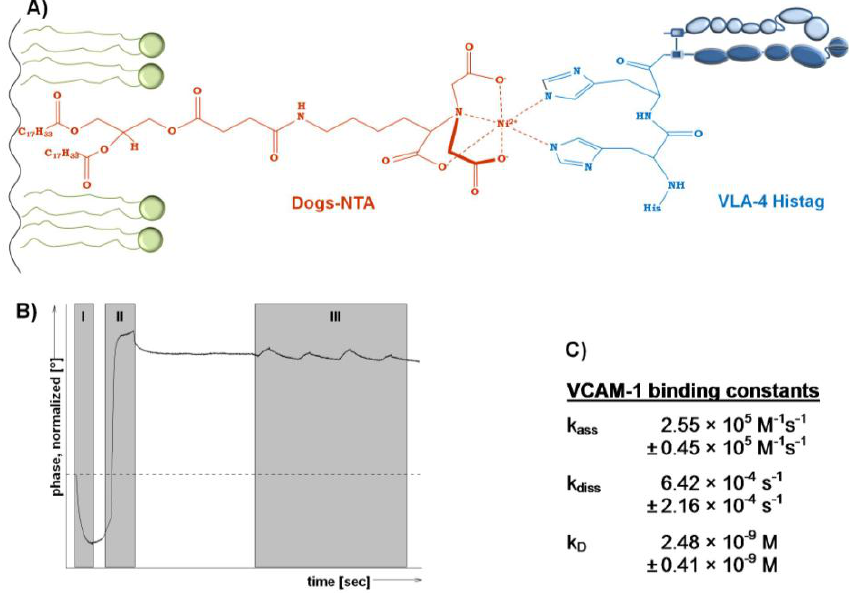
Figure 3. SAW detection of the VLA-4/VCAM-1 binding affinity using a trehalose protected model membrane approach. ( A ) Scheme of an immobilized PL mixture (colored green) with the chelating lipid DGS-NTA to interact with the His-tagged integrin VLA-4 at the membrane surface; ( B ) SAW sensorgram of the reconstitution of the dried membrane and trehalose replacement (I) followed by in situ integrin immobilization (II) and interaction with increasing concentrations of VCAM-1 (III) in real time; ( C ) Kinetic calculations from the sensorgram lead to binding affinities in the nanomolar